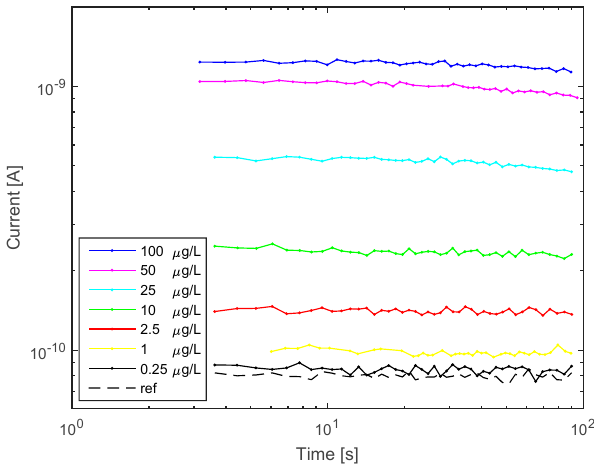
Figure 5. Mercury-induced bioluminescence detected by the SiPM sensor: E. coli reporter samples treated with 0 (reference, black line); 0.25 (yellow line); 1 (green line); 2.5 (purple line); 10 (blue line); 25 (red line); 50 (brown line) and 100 (light blue line) µg/L Hg 2+ , for 1 h; signal measurement time: 1 min.